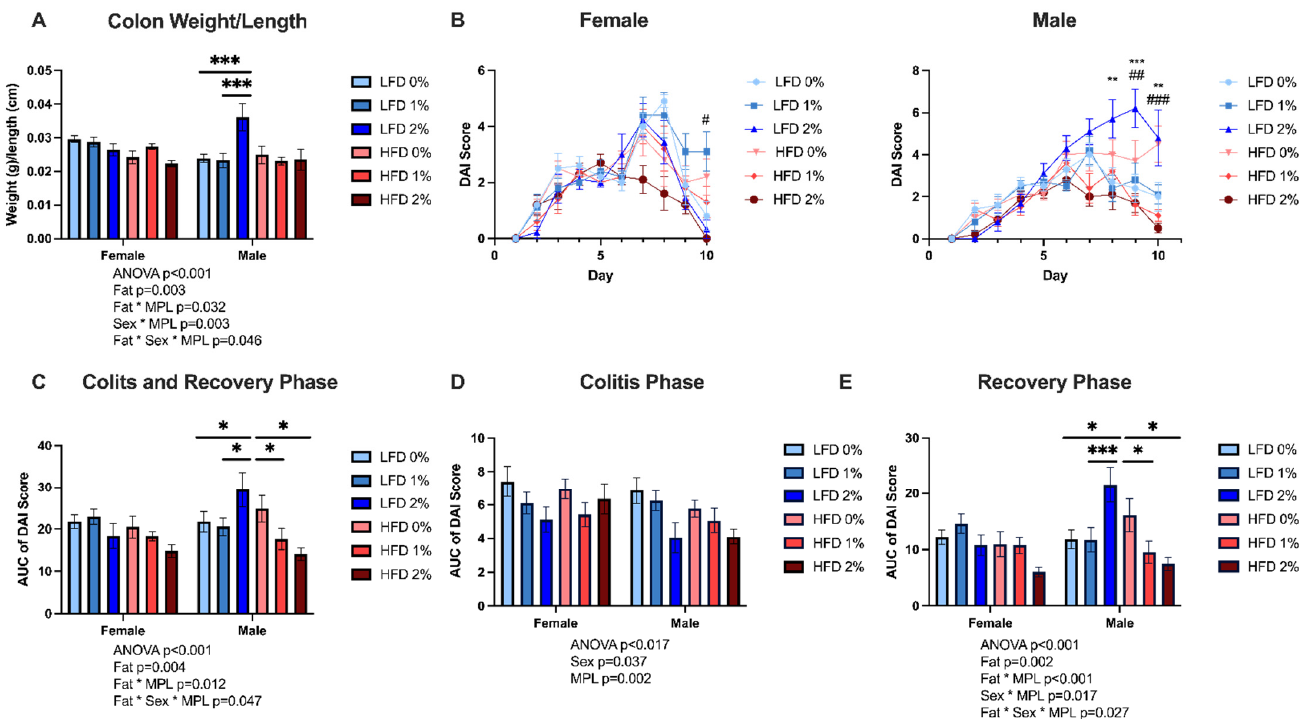
Figure 2. MPLs exacerbate colitis in LFD but attenuate colitis in HFD. ( A ) Colon weight/length ratios. ( B ) Daily DAI scores of female and male mice over the colitis induction and recovery periods. Area under the curve (AUC) of the DAI scores of male and female mice over the 10-day DSS protocol ( C ), and during the colitis induction ( D ), and recovery periods ( E ). For panel B, ** indicates p -value < 0.01 for LFD 2% vs. 0% *** indicates p -value < 0.001, # indicates p -value < 0.05 for HFD 2% vs. 0%, ## indicates p -value < 0.01 for HFD 2% vs. 0%, ### p -value < 0.001 for HFD 2% vs. 0%. For panels A and C-E, * p -value <0.05, *** p -value <0.001 using three-way ANOVA with Fisher’s least significant difference for multiple comparisons. Values reported as mean ± standard error of the mean, n = 10/sex/group.